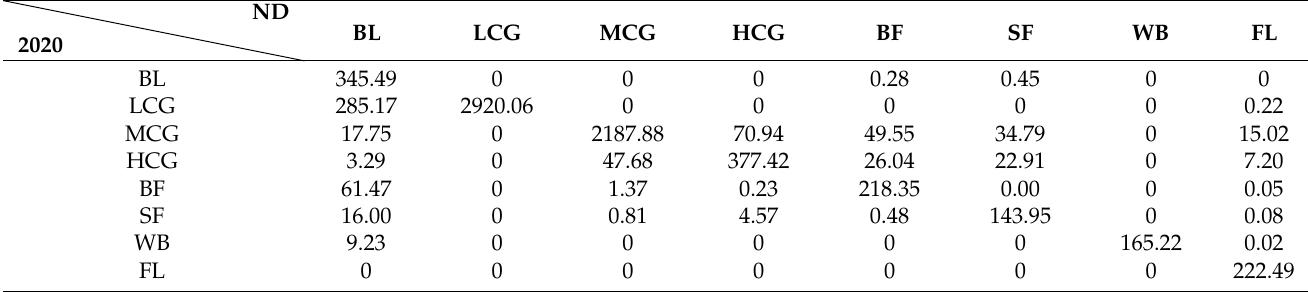
Table A8. Ecosystem service value changes from 2020 to 2030 ND (106 yuan).